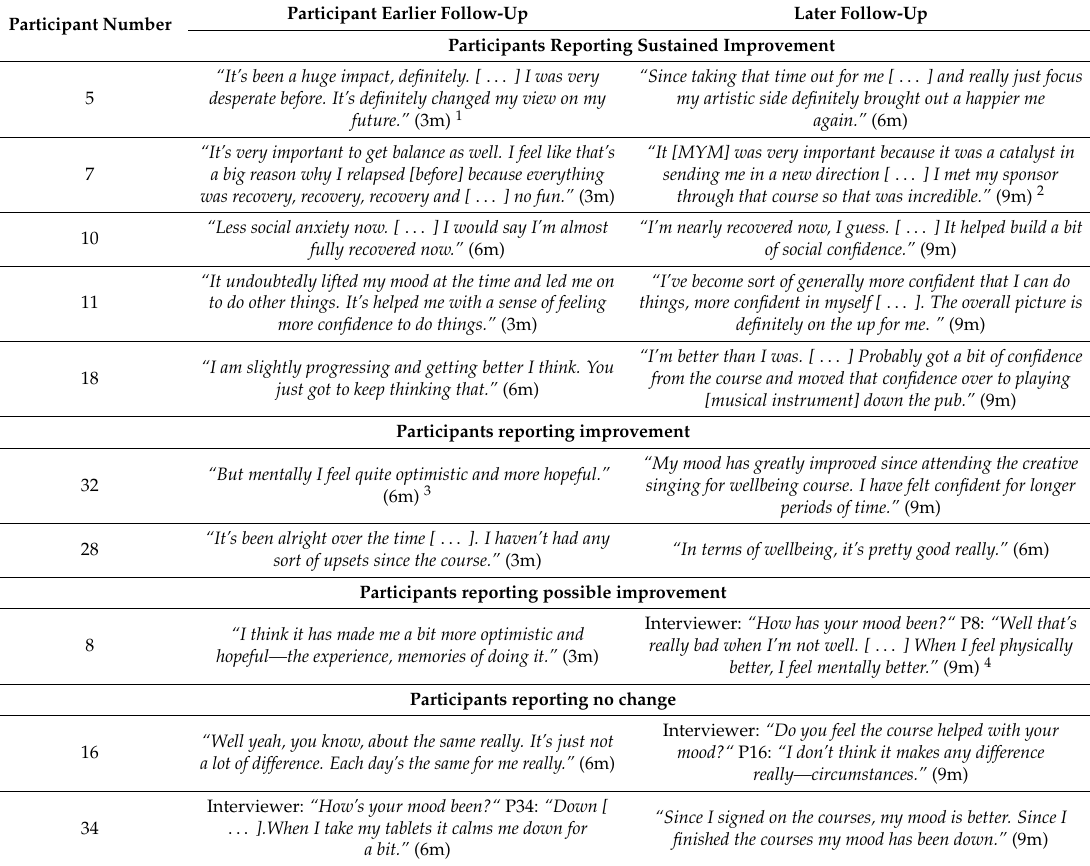
Table 8. Quotations illustrating self-reports of improvement and no